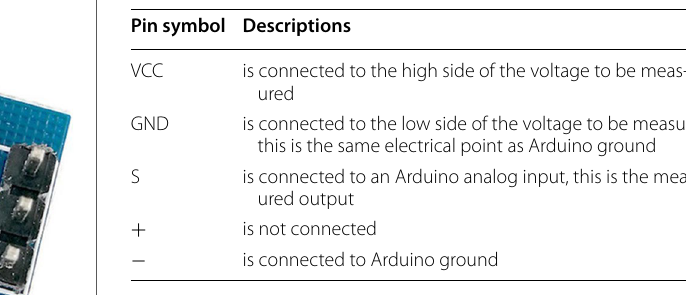
Table 3 Connectors of the F031-06 voltage sensor